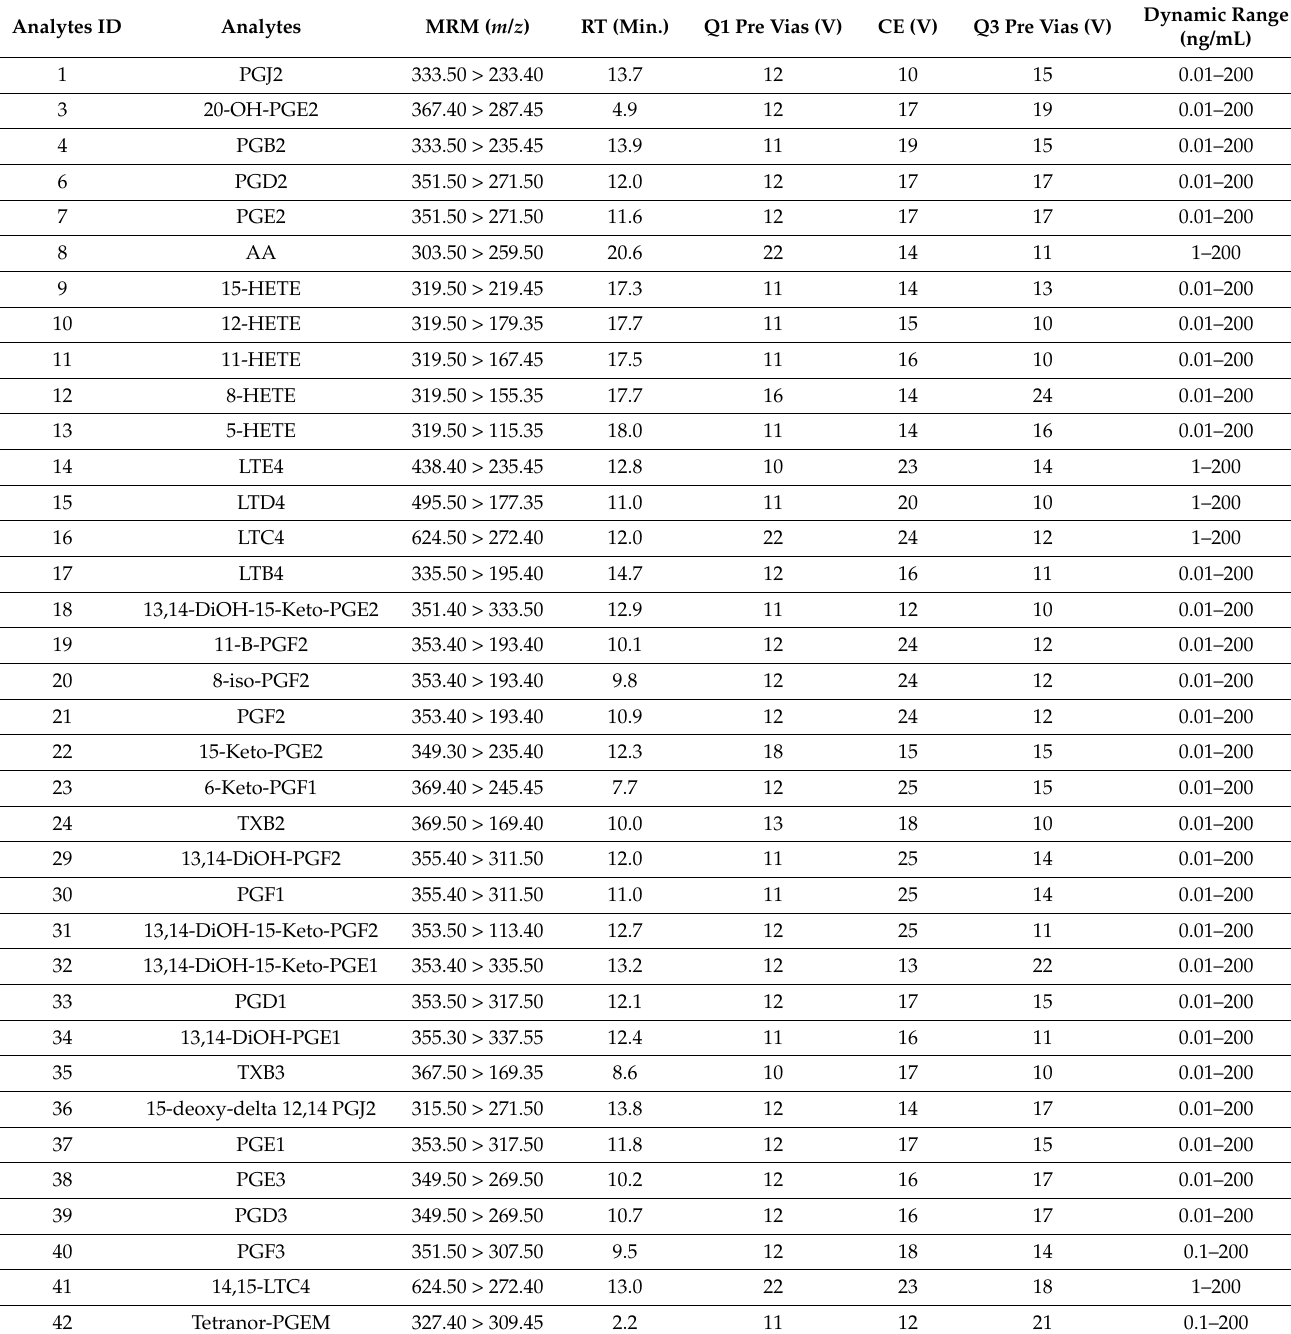
Table 1. Summary of multiple reaction monitoring (MRM) ( m / z ), retention time (RT), Q1 pre-rod potential, collision energy (CE), Q3 pre-rod potential, and dynamic range of all 66 eicosanoids and internal standards (IS). Analytes